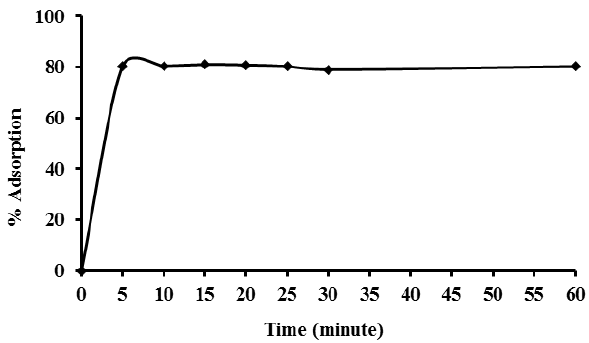
Figure 6: Effect of contact time on the adsorption of amoxicillin by